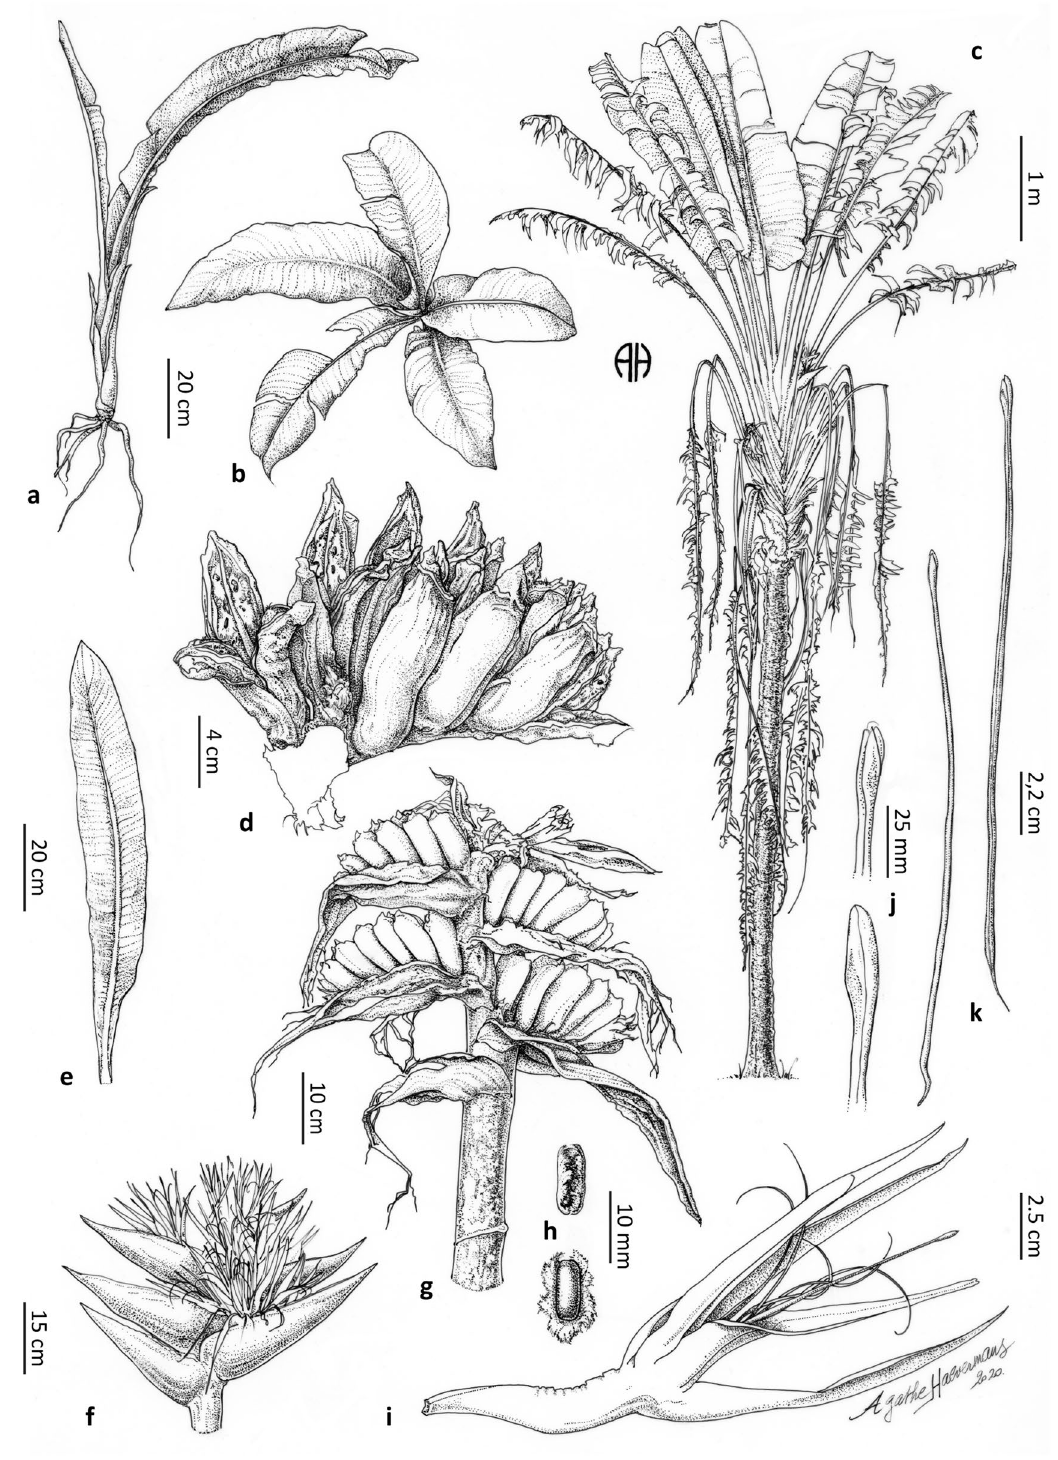
Figure 7. Ravenala blancii . ( a ) juvenile plant habit with roots. ( b ) juvenile plant showing the arrangement of laminae. ( c ) adult plant habit. ( d ) mature infructescence segment. ( e ) juvenile leaf showing the attenuate base of the lamina. ( f ) inflorescence with sub-simultaneous opening of the flowers. ( g ) young infructescence with already degraded bracts. ( h ) seeds with arilla. ( i ) open flower. ( j ) details of the stigma. ( k ) style. Ink drawings on 75 µ polyester tracing paper by Agathe Haevermans© from specimens Hladik 6790, 6239, 6650, Haevermans et al. 832 , and observations